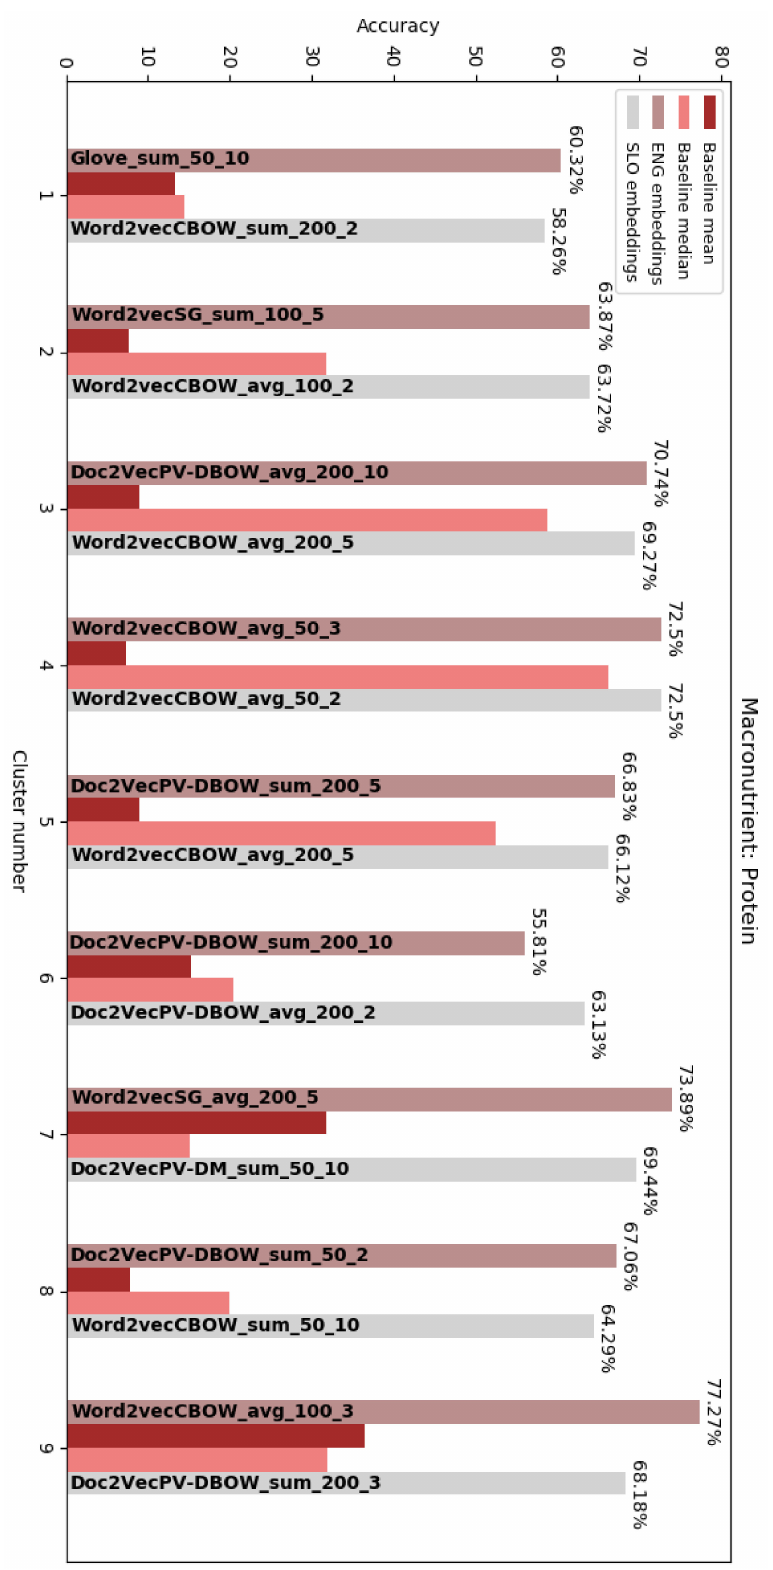
Figure 4. Best prediction accuracies for protein predictions obtained from the embeddings for the English names and Slovene names for each cluster compared to the baseline mean and median for the particular